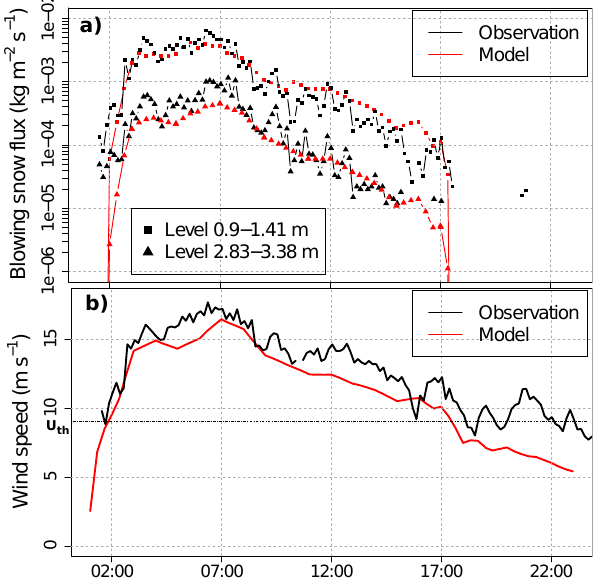
Fig. 8. (a) Blowing snow fluxes simulated by Meso-NH/Crocus and measured by SPC at two levels above the snowpack. Each flux sim- ulated by the model has been interpolated using a power law at the height of the considered SPC. This latter changed during the blowing snow event due to snow erosion and accumulation below SPC. Particles fluxes higher than 100 partcm − 2 s − 1 are considered as non-negligible. (b) 2m wind speed simulated by Meso-NH and measured close to the SPC. The dashed-dotted black line indicates the threshold wind speed, U th